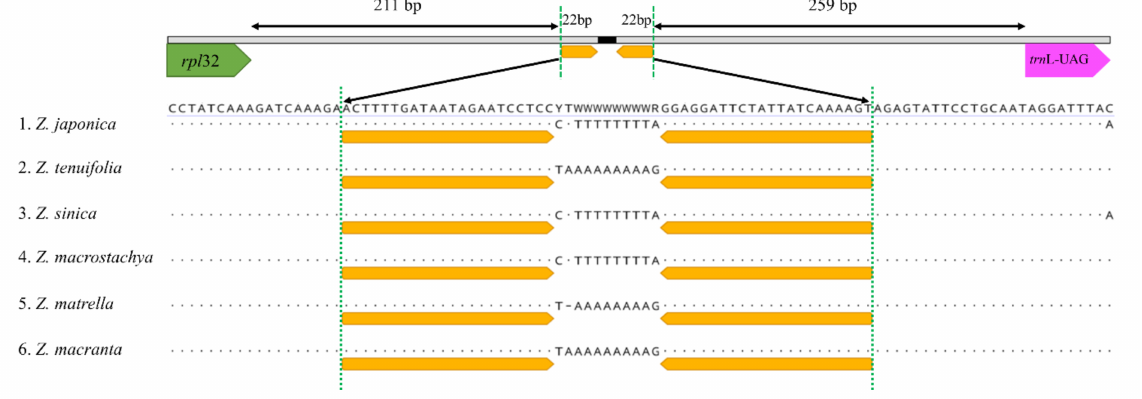
Figure 4. The sequence difference between the rpl32 and trnL-UAG genes among six Zoysia species. All six species of Zoysia have an 11 bp long loop region, but this region has a different orientation in Z. japonica , Z. sinica , and Z. macrostachya compare to that of Z. tenuifolia , Z. matrella , and Z. macrantha . This difference is due to a small inversion at the 22 bp long stem region (orange